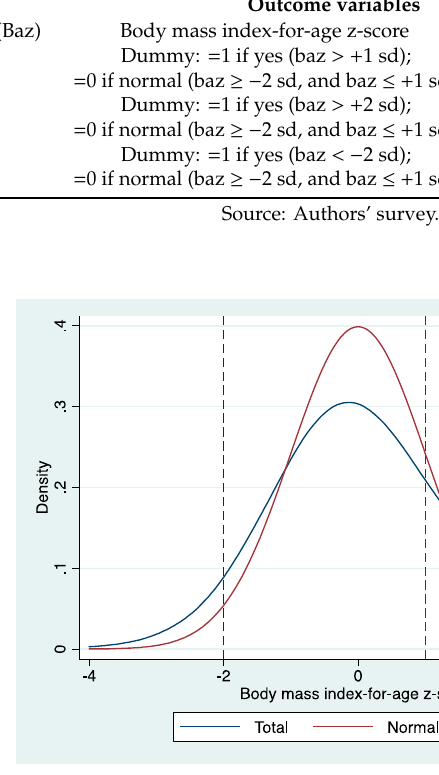
Figure 1. Distribution of body mass index-for-age z-score for entire sample and normal distribution (Mean = 0, Standard deviation = 1).